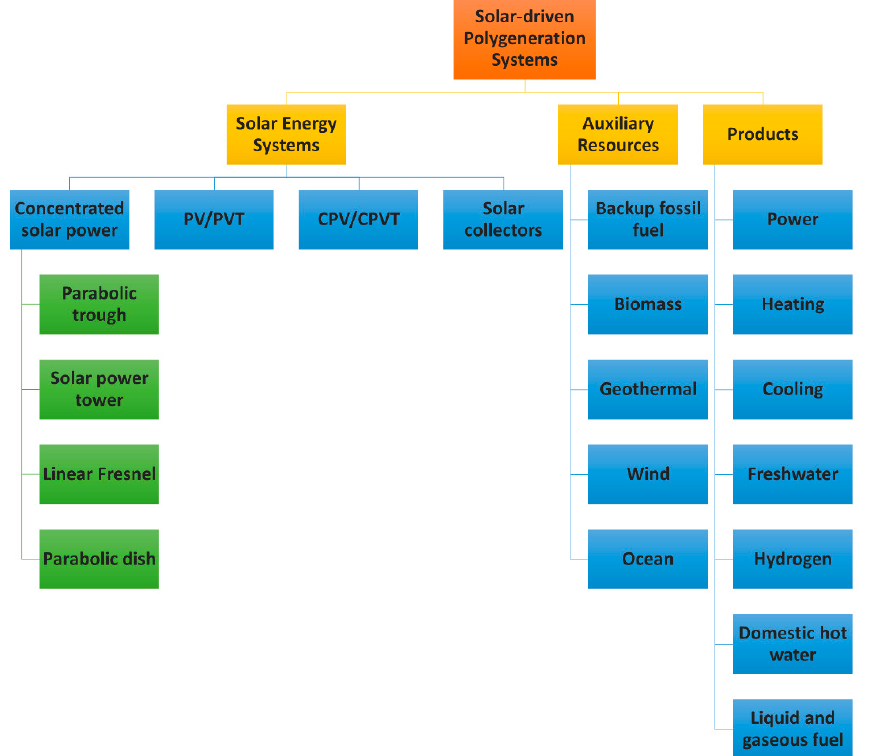
Figure 6. Solar-driven polygeneration systems [64]. CPV, concentrated photovoltaic; CPVT, concentrated photovoltaic thermal; PV, photovoltaic; PVT, photovoltaic thermal.